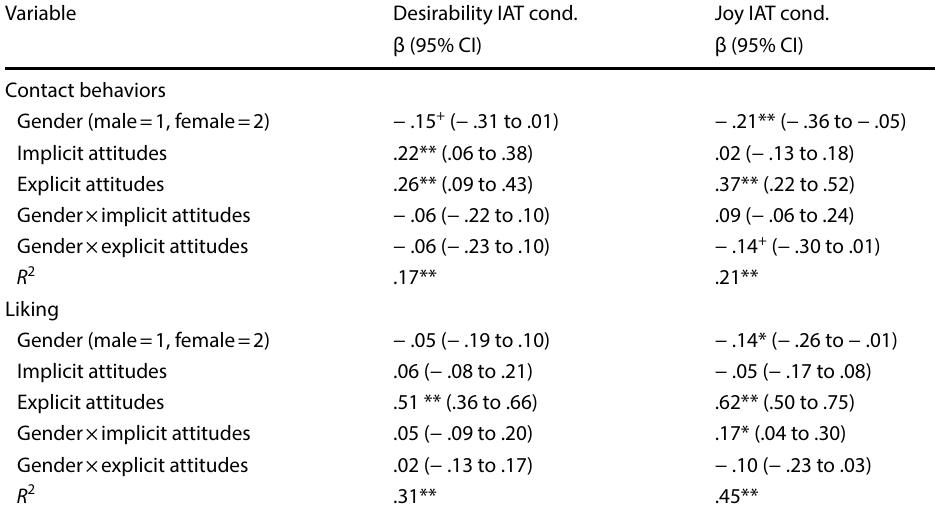
Table 4 Results of multiple regression analysis on behaviors related to sports and